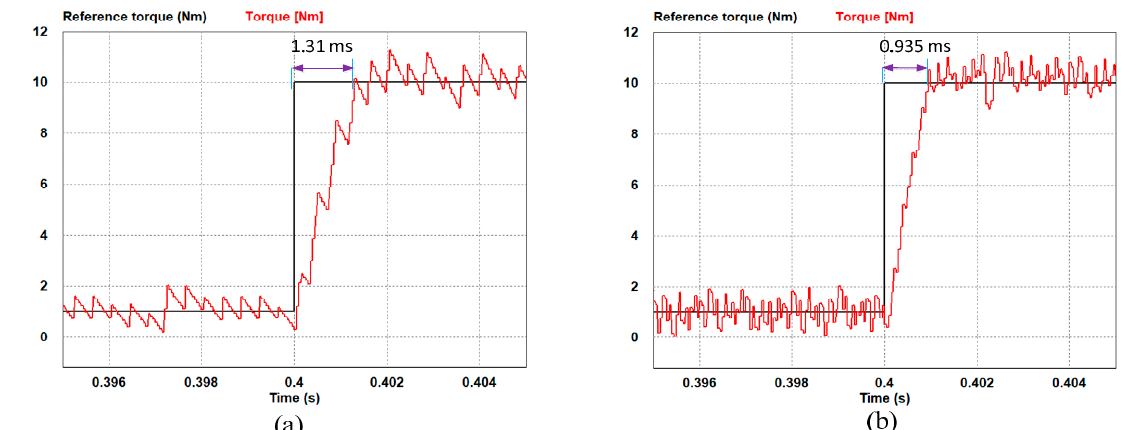
Figure 6. Enlargement of simulation results shown in Figure 5 for CFTR-DTC with ( a ) single carrier and ( b ) interleaving carriers.